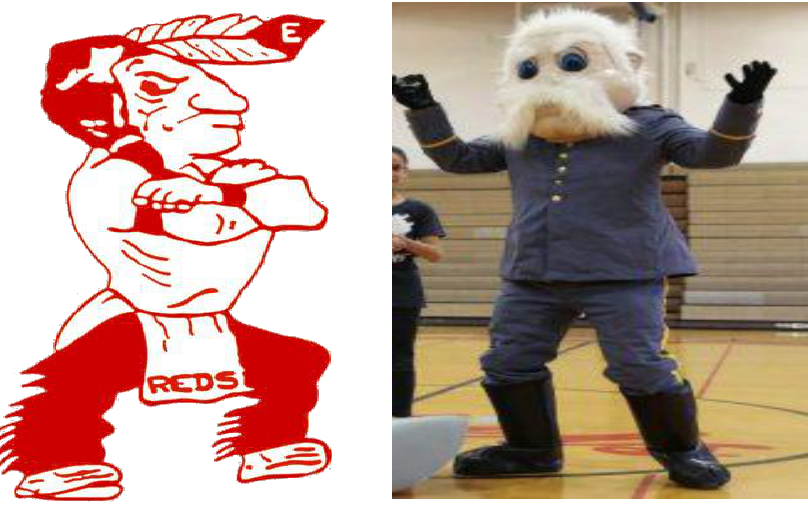
IMAGE 4 . THE EATON HIGH SCH OOL “FIGHTING REDS” & THE WELD CENTRAL H IGH SCHOOL “REBELS” MASCOT. NOTE: THE WELD CENTRAL HIGH SCHO OL “REBEL” REBEL MAS COT REPRESENTED IN FILE ABOVE IS ALSO THE MASCOT OF WELD CENTRAL MIDDLE SCHOOL. PHOTO COURTESY OF THE GREELEY